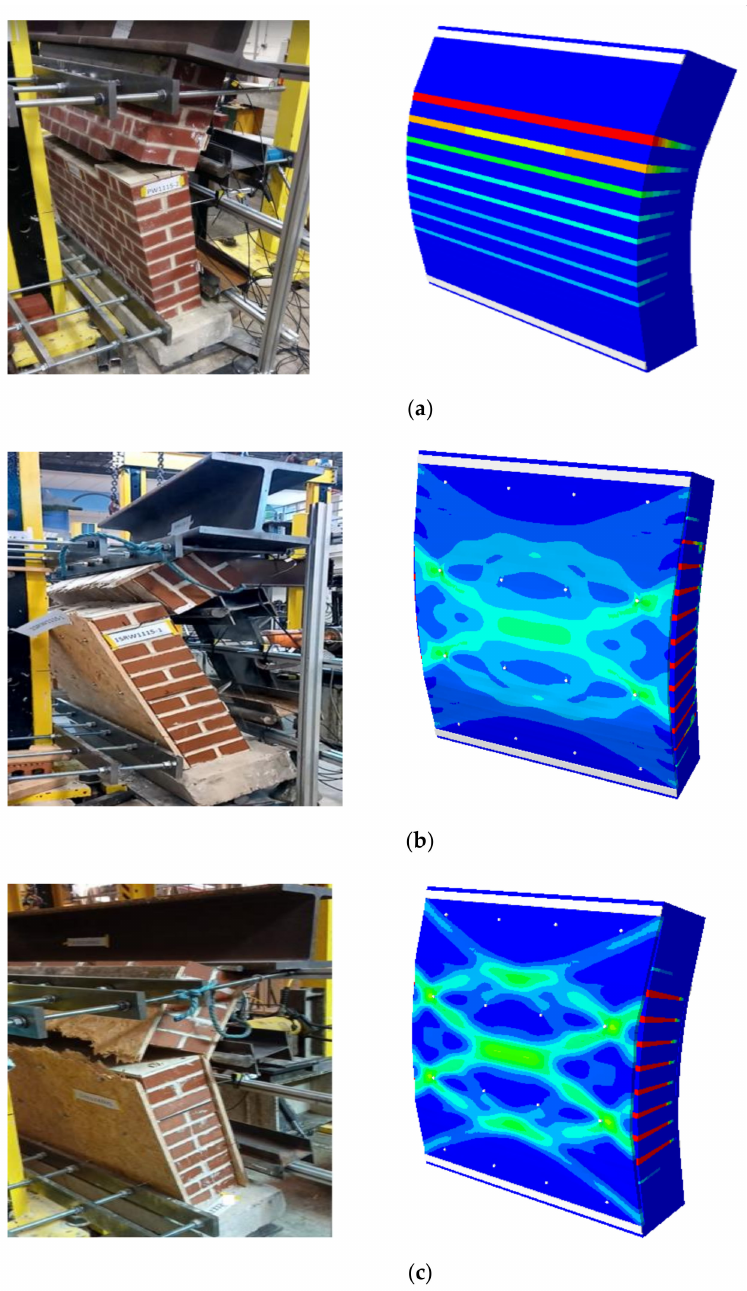
Figure 19. Failure pattern of large-scale wall (experimental and FE model): ( a ) plain wall (PW1115), ( b ) one side retrofitted wall (1SRW1115), ( c ) Double side retrofitted wall